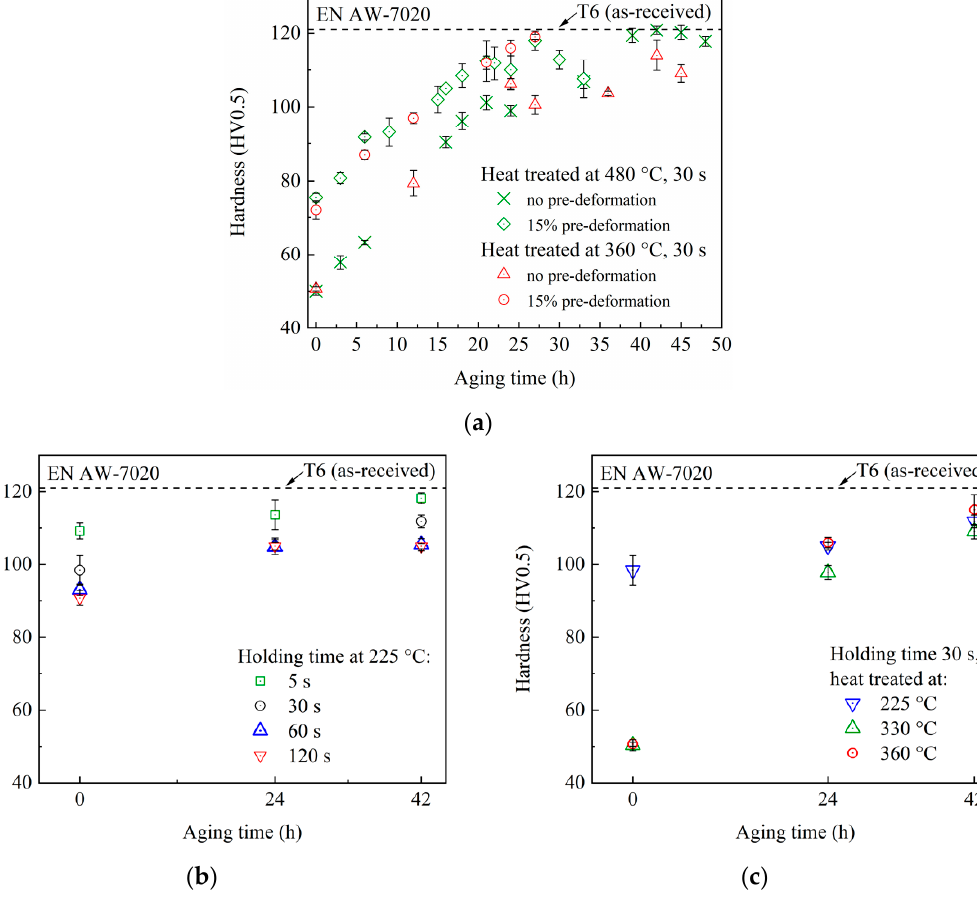
Figure 5. Evolution of the hardness during artificial aging of the alloy EN AW-7020 after various thermo-mechanical processes. ( a ) Effect of pre-deformation after SHT (at 480 °C) or retrogression at 360 °C, with a holding time of 30 s. ( b ) Effect of holding time during retrogression at 225 °C. ( c ) Effect of temperature during retrogression with a holding time of 30 s.